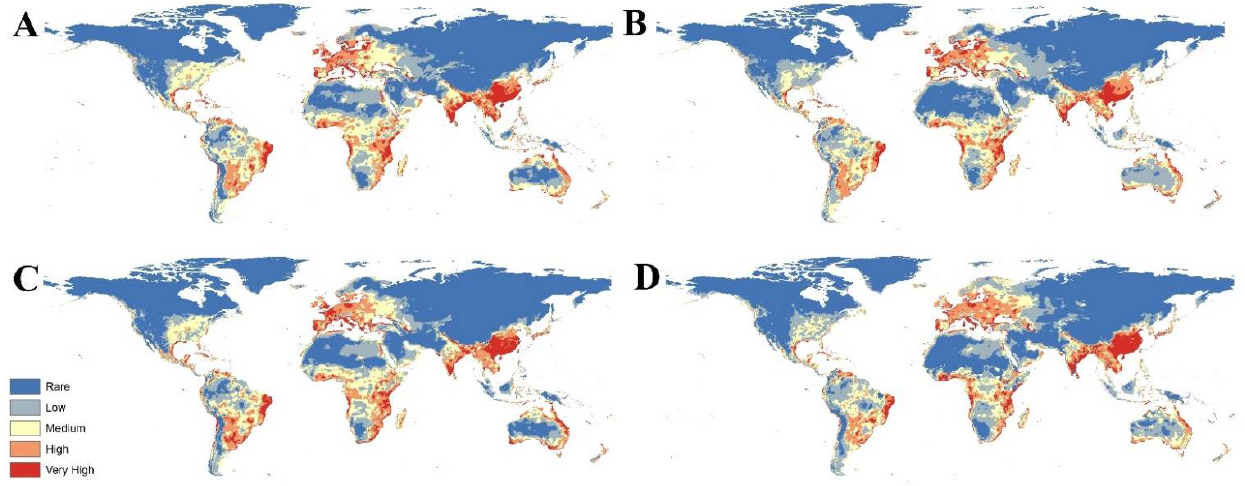
Figure 3. Prediction of global future distribution of A . niger under two RCPs: ( A ) 2050 for RCP 2.6; ( B ) 2050 for RCP 8.5; ( C ) 2070 for RCP 2.6, and ( D ) 2070 for RCP 8.5.